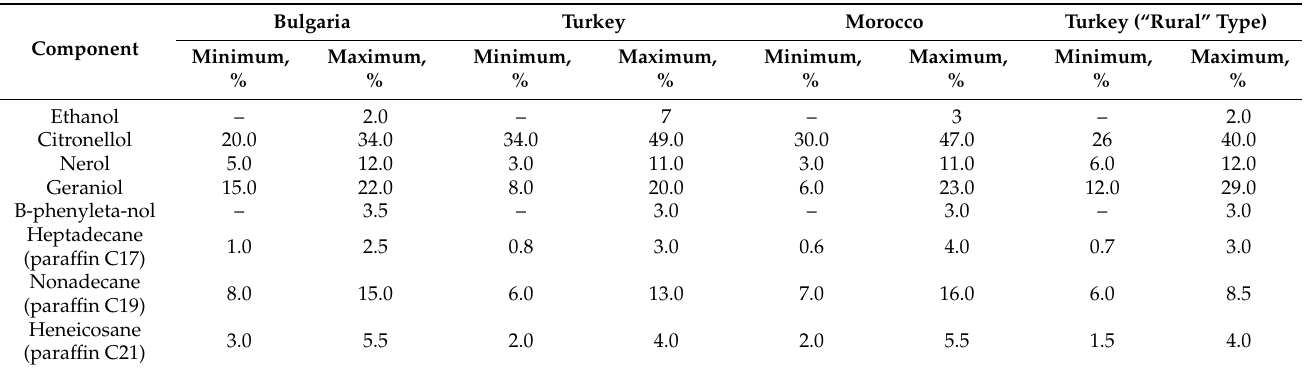
Table 2. GOST ISO 9842-2017 standard requirements for the rose essential oil major component contents for multiple